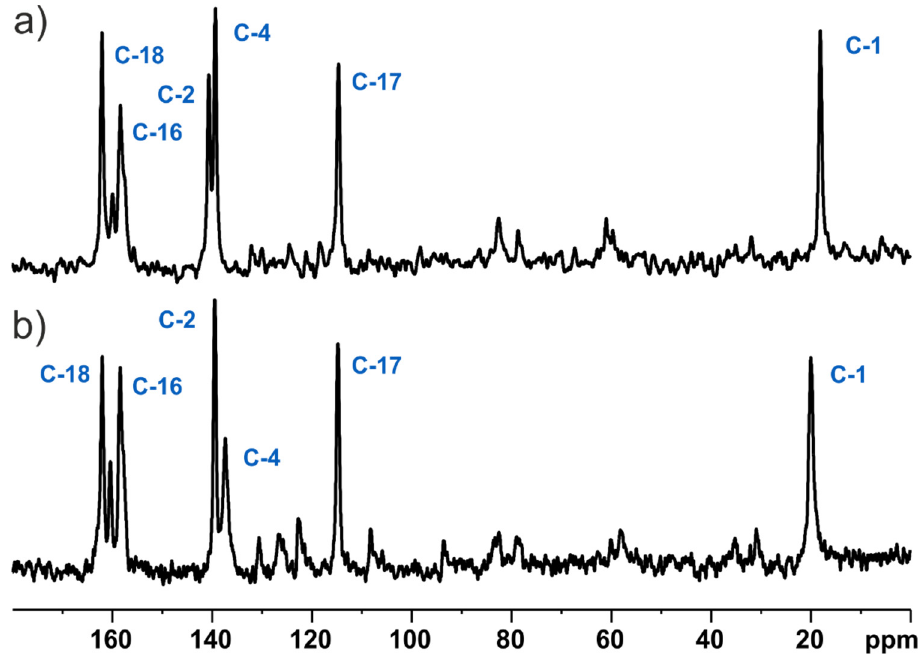
Figure 8. 13 C DD CP MAS NMR spectra of MBS ( a ) and MBS HCl ( b ) recorded at a spinning rate of 8 kHz at an ambient temperature. Dephasing delay was 50 μ s.